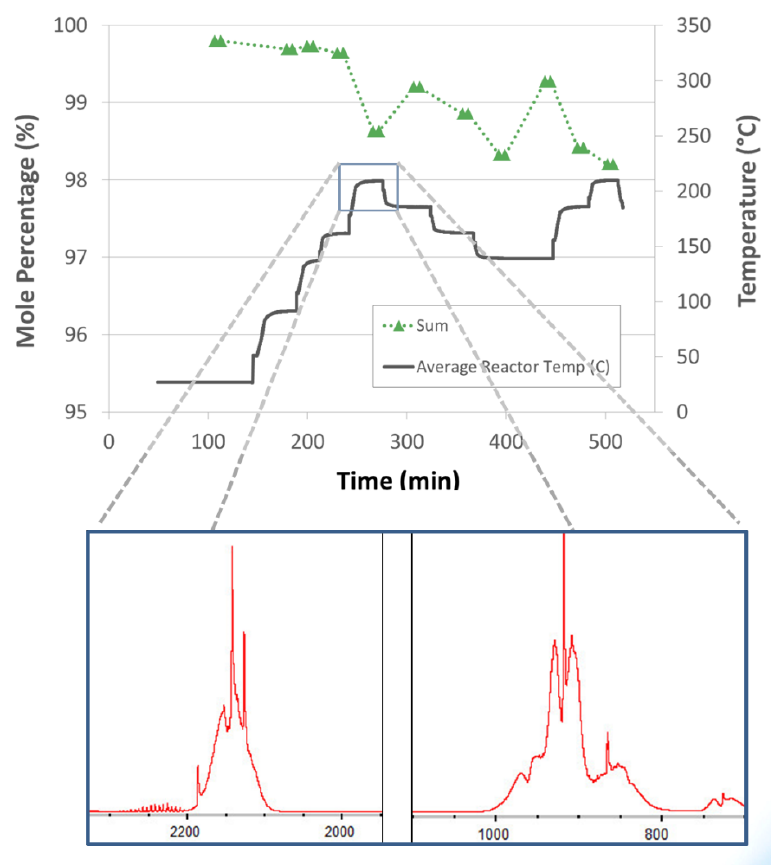
Figure 14. IR spectra of Si-H transitions observed with silicone oil-based alane slurries for reactor temperatures around 200 °C indicating an alane/aluminum side reaction with the silicone oil carrier (abscissa units are cm −1 ).